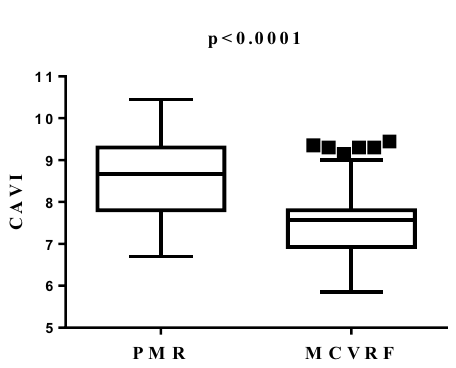
Figure 2. CAVI values (right/left side mean values) in patients with PMR (n = 48) and MCVRF controls (n = 56). Data are shown as Tukey boxplots; lines represent the median level with 25th–75th percentile; data not included between the whiskers are plotted as outliers with dots. CAVI cardio-ankle vascular index, PMR polymyalgia rheumatica, MCVRF major cardiovascular risk factors.